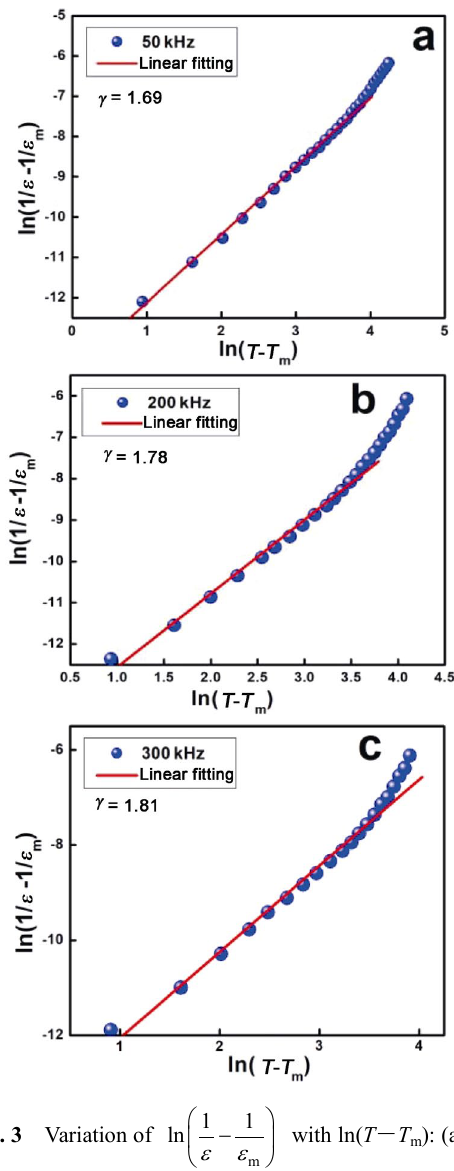
ε  1 1 −  with ln( T － T m ): (a) 50, ln ε   m